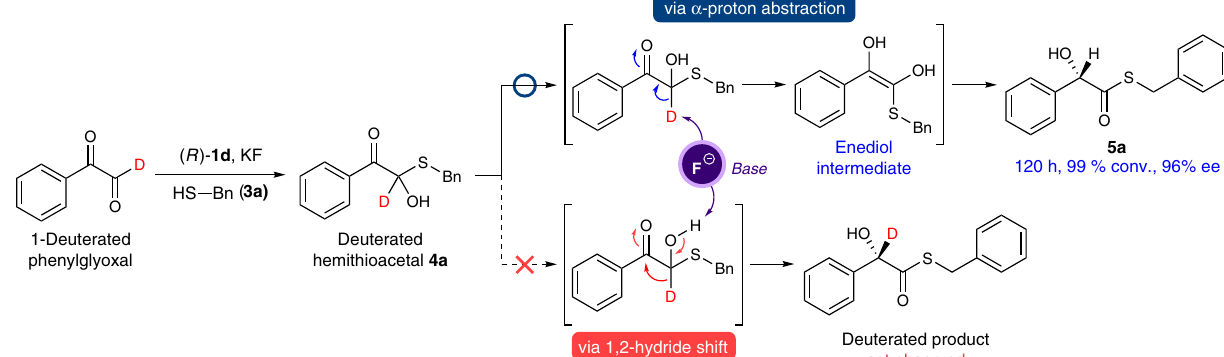
Figure 4 | Synthetic utility. ( a ) Pharmaceutically important chiral a -hydroxyamides. ( b ) Synthesis of BMS 270394 and LY 411575 by coupling-reagent-free